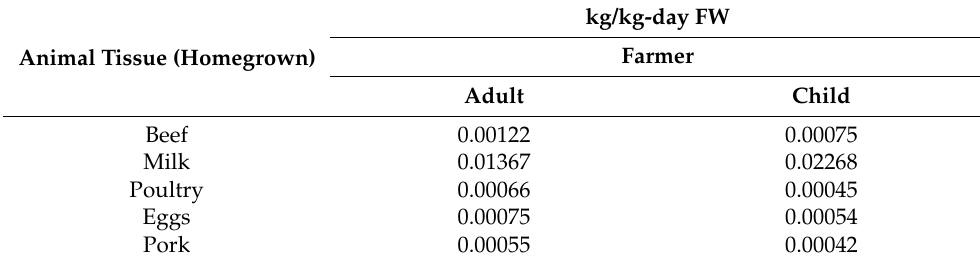
Table 18. Recommended Default Animal Tissue Consumption Rate Values.